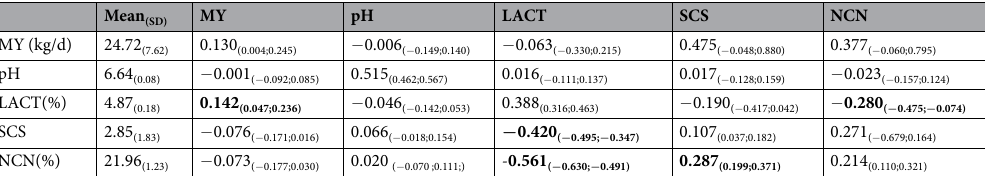
Table 1. Descriptive statistics, genomic (upper triangular) and residual (lower triangular) correlations, and genomic heritabilities (diagonals) for the milk traits. MY: milk yield; LACT: lactose; SCS:somatic cells score, calculated as log2 (somatic cell count/100,000) + 3; NCN: casein (non-casein N expressed as % of total milk N) Lower and upper bounds of the highest 95% probability density regions (HPD95) obtained from the estimated marginal densities are given in parantheses. Relevant correlations (HPD95 not including 0) are highlighted in